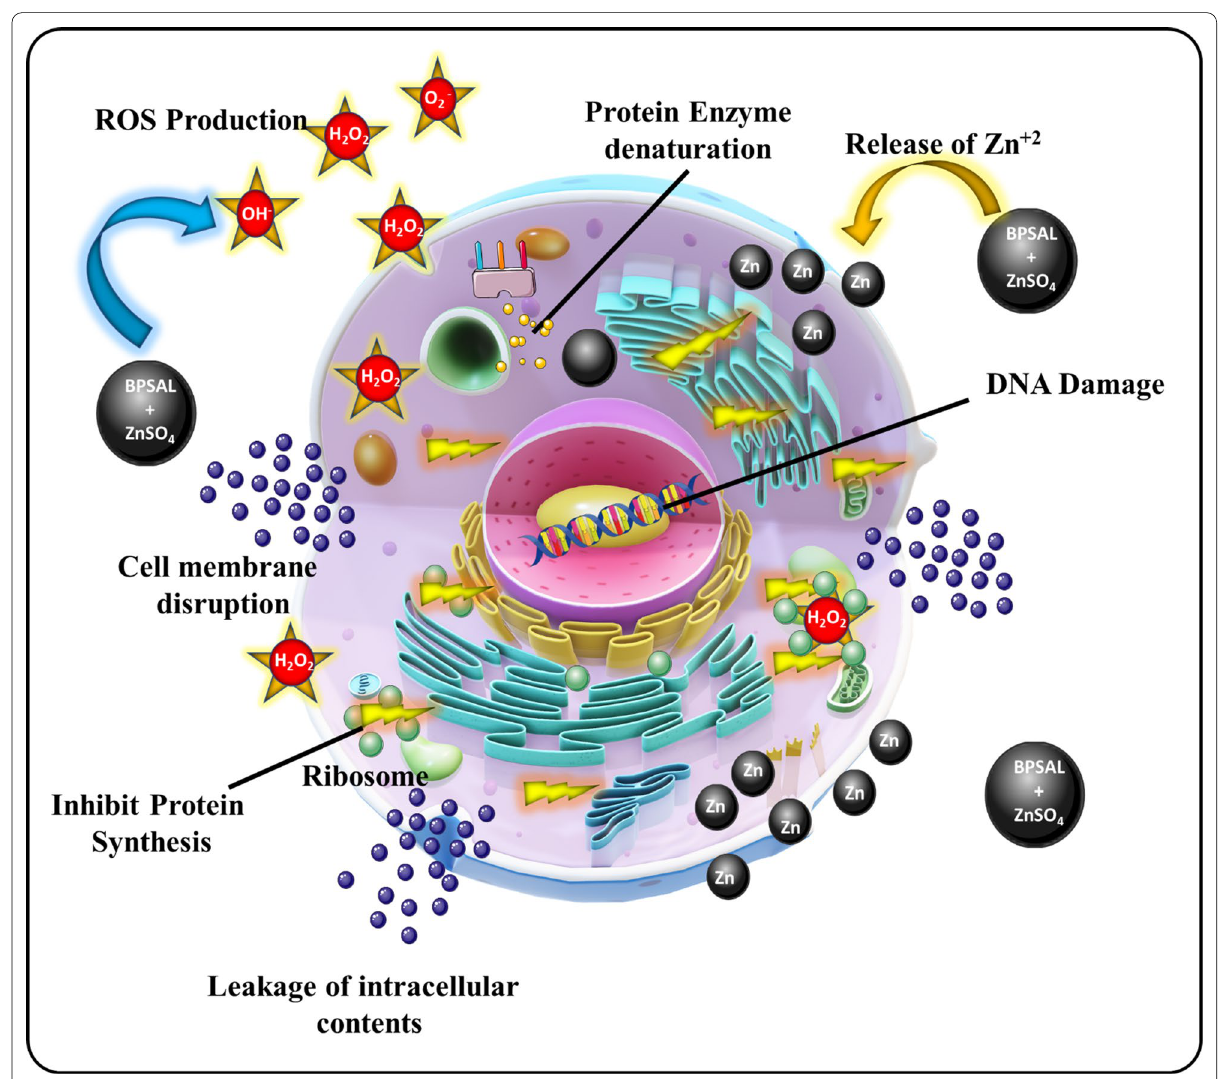
Fig. 16 Role of zinc ion in diabetes. BPSAL along with ZnSO 4 when enters into the cells converts into Zn into the cell disturb the cell potential and positive ions inside the cell capture the various ROS such as OH − , NO − , H 2 O 2 , etc., which causes the degradation of ribosomes, cell membrane disruption, DNA damage and protein denaturation